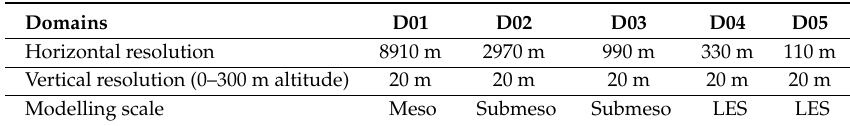
Table 2. Domains, Resolutions and Scales implemented in the WRF 3.8.1 modelling applied to the France zone up to the zoom on